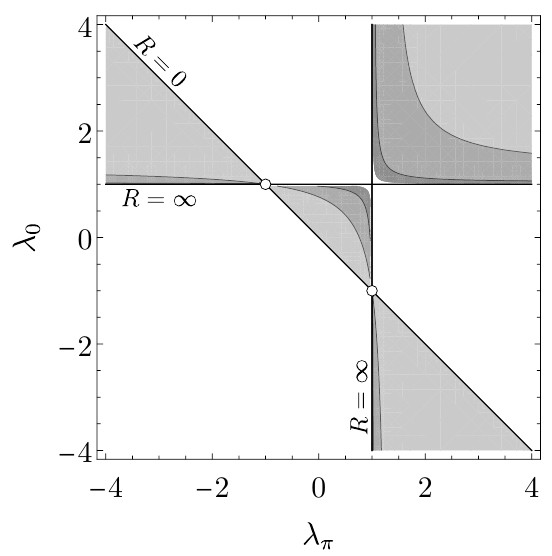
Figure 1. Allowed regions ((cid:12)lled) for the normalized brane tensions (cid:21) 0 ; (cid:21) (cid:25) . The contours illustrate the value of R = R RS (darker means bigger) such that H = 0. At the solid boundary lines R asymptotes the values indicated in the plot. Values (cid:22)(cid:25)R RS (cid:25) 70, for which the desired hierarchy between M Pl ; e(cid:11) and M is obtained, lie very close to the vertical and horizontal boundary lines. Empty circles show the choice of brane tensions in the original Randall-Sundrum scenario, where H = 0 while R at these points can take any